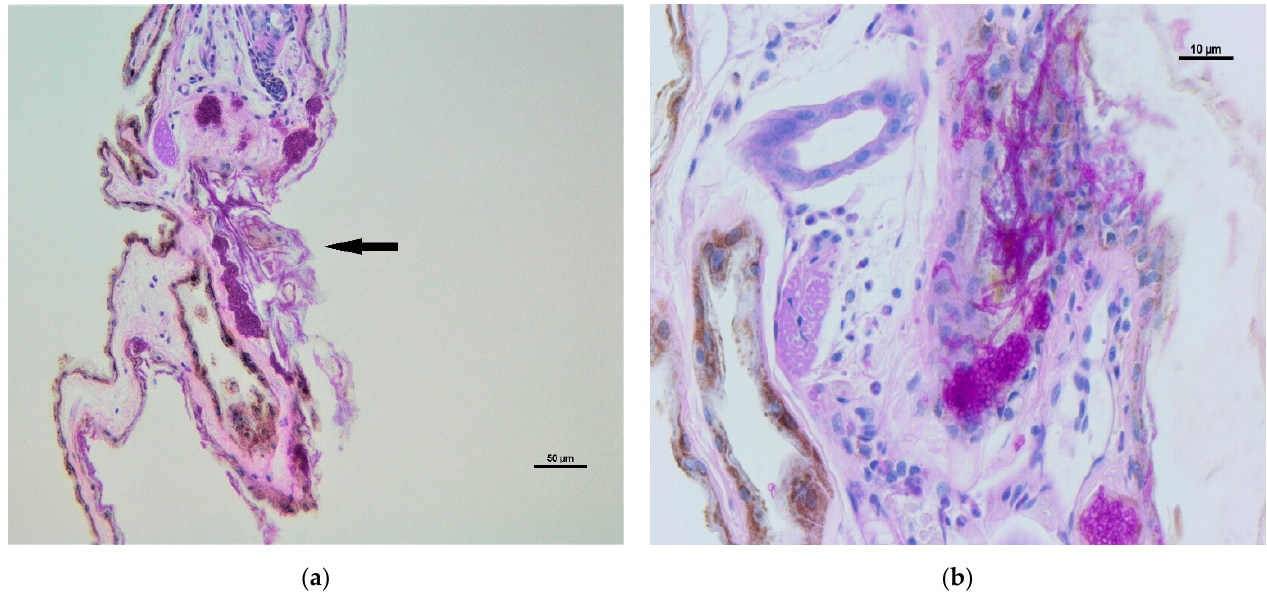
Figure 2. Wing membrane: ( a ) epidermal erosion and ulceration with moderate dermal infiltration (arrow) and fungal hyphae; ( b ): detail of fungal hyphae infiltration in glands and derma (arrows) with mild inflammatory infiltration (mononucleated cell and rare neutrophils). Periodic Acid Schiff (PAS) stain.